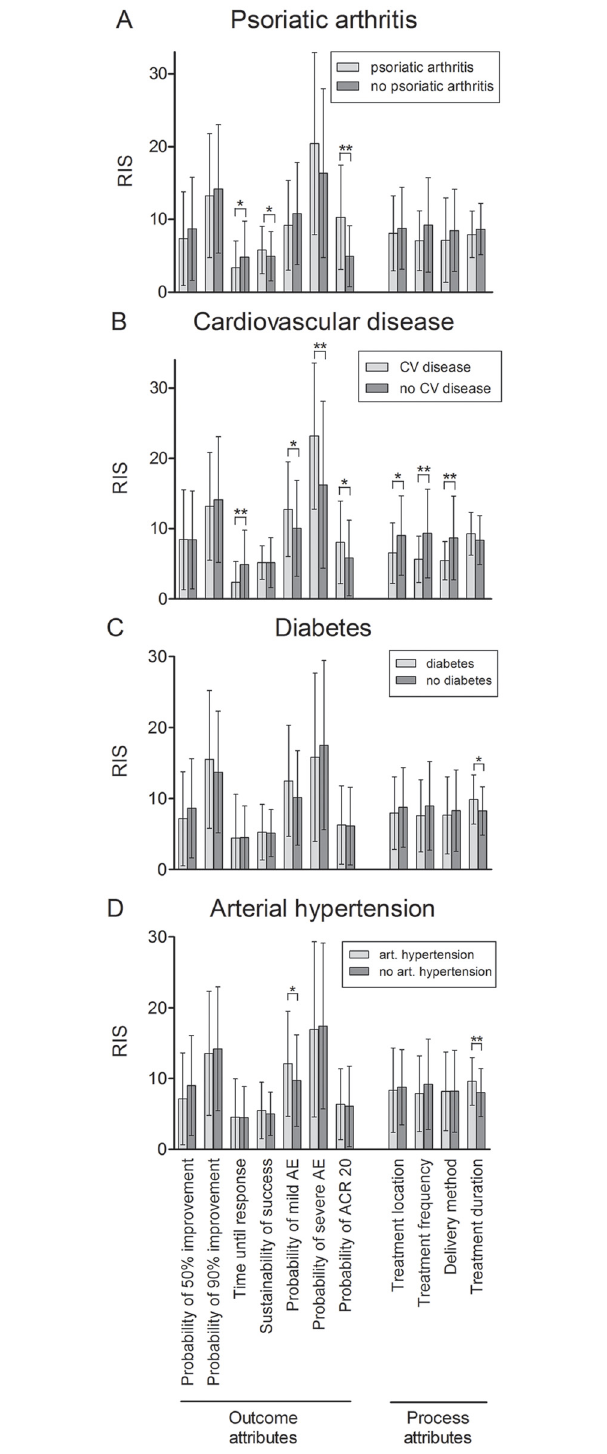
Fig 1. Impact of comorbidities on preferences for outcome and process attributes of biologicals. (A) Participants with psoriatic arthritis attached higher value to probability of ACR 20 response and sustainability but less importance to time until response. (B) Respondents with cardiovascular disease prioritized avoidance of mild and severe AE as well as ACR 20 response. Time until response, treatment location, frequency and delivery method were less relevant for them than for other participants. (C) Participants